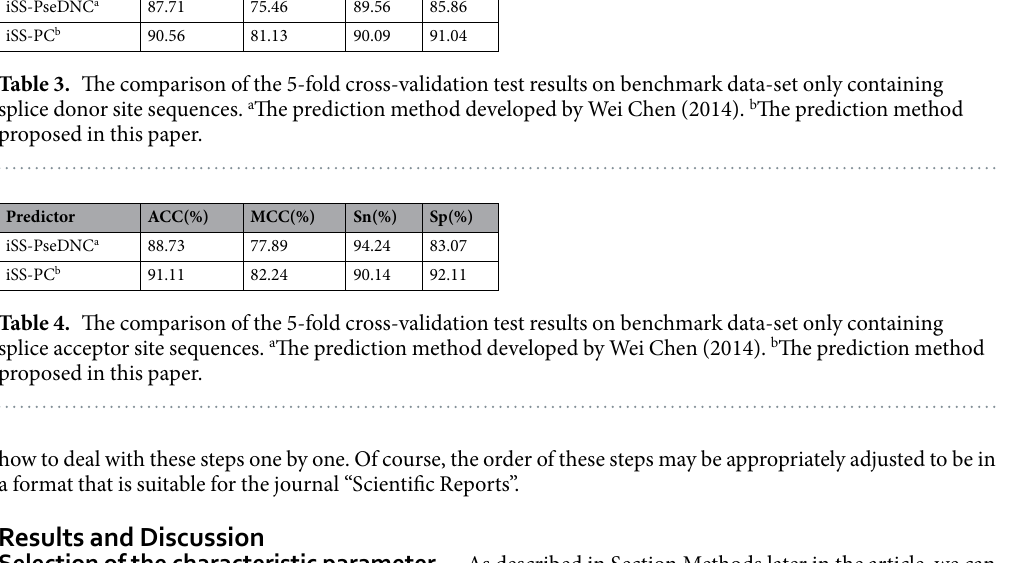
Predictor ACC(%) MCC(%)